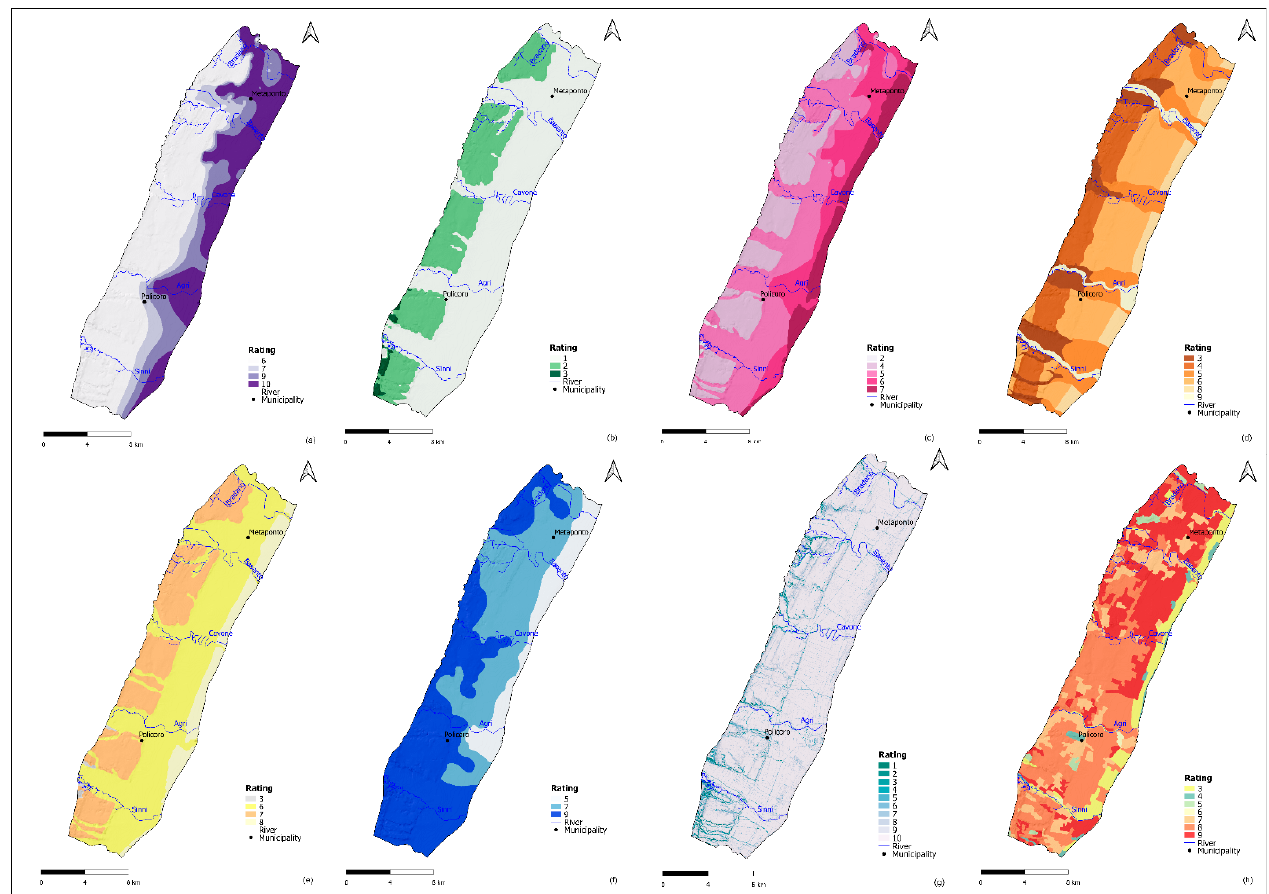
Figure 4. The thematic maps for SINTACS and SINTACS-LU methods: ( a ) water table depth; ( b ) effective infiltration; ( c ) unsaturated zone; ( d ) soil media; ( e ) aquifer media; ( f ) hydraulic conductivity; ( g ) topography; ( h ) land use.